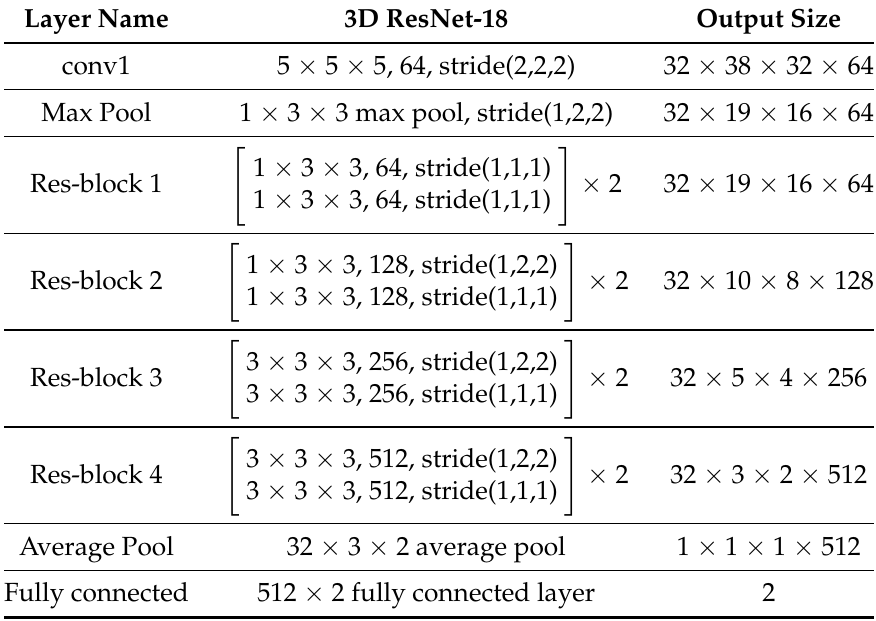
Table 1. ResNet-18 architecture. Network architecture for 3D ResNet-18 model used for corr (fMRI, ROI) feature extraction. Building blocks are shown in brackets, with the numbers of blocks